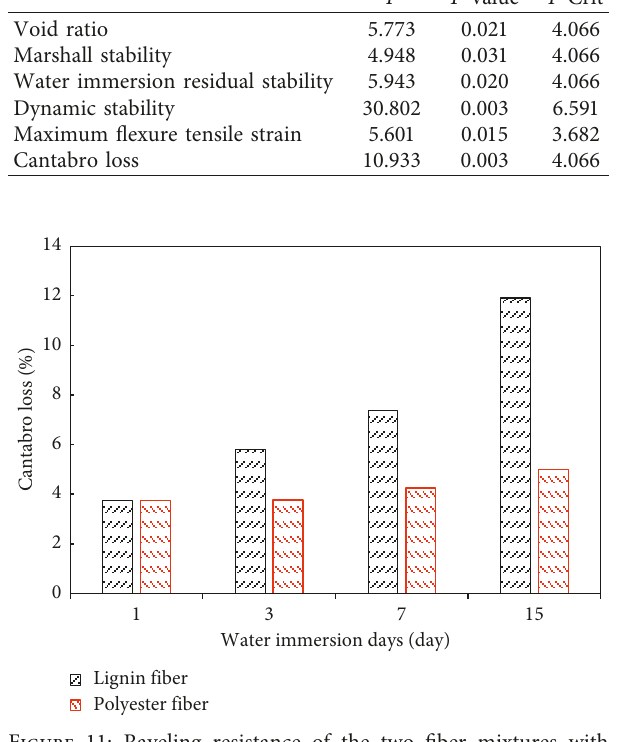
Figure 11: Raveling resistance of the two fiber mixtures with different water immersion days.